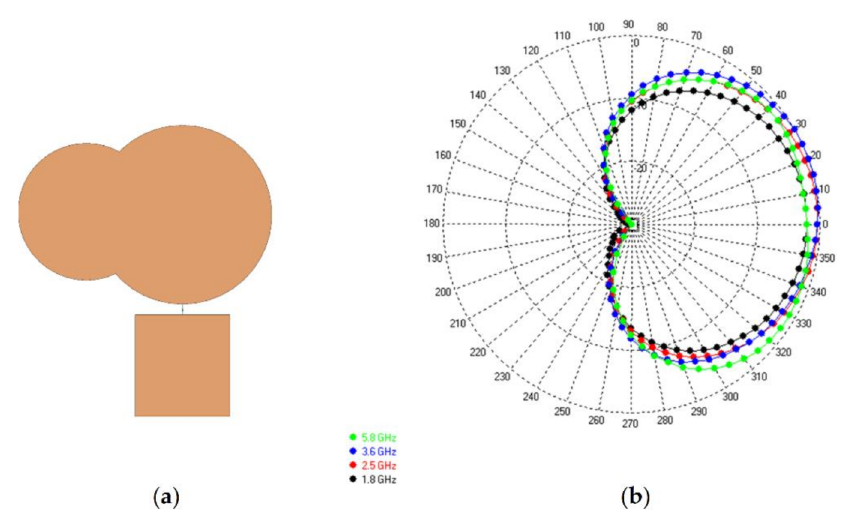
Figure 11. Two circle antennae optimized with Pareto Estra algorithm: ( a )—antenna geometry. ( b )—radiation pattern in x-z plane for on-body